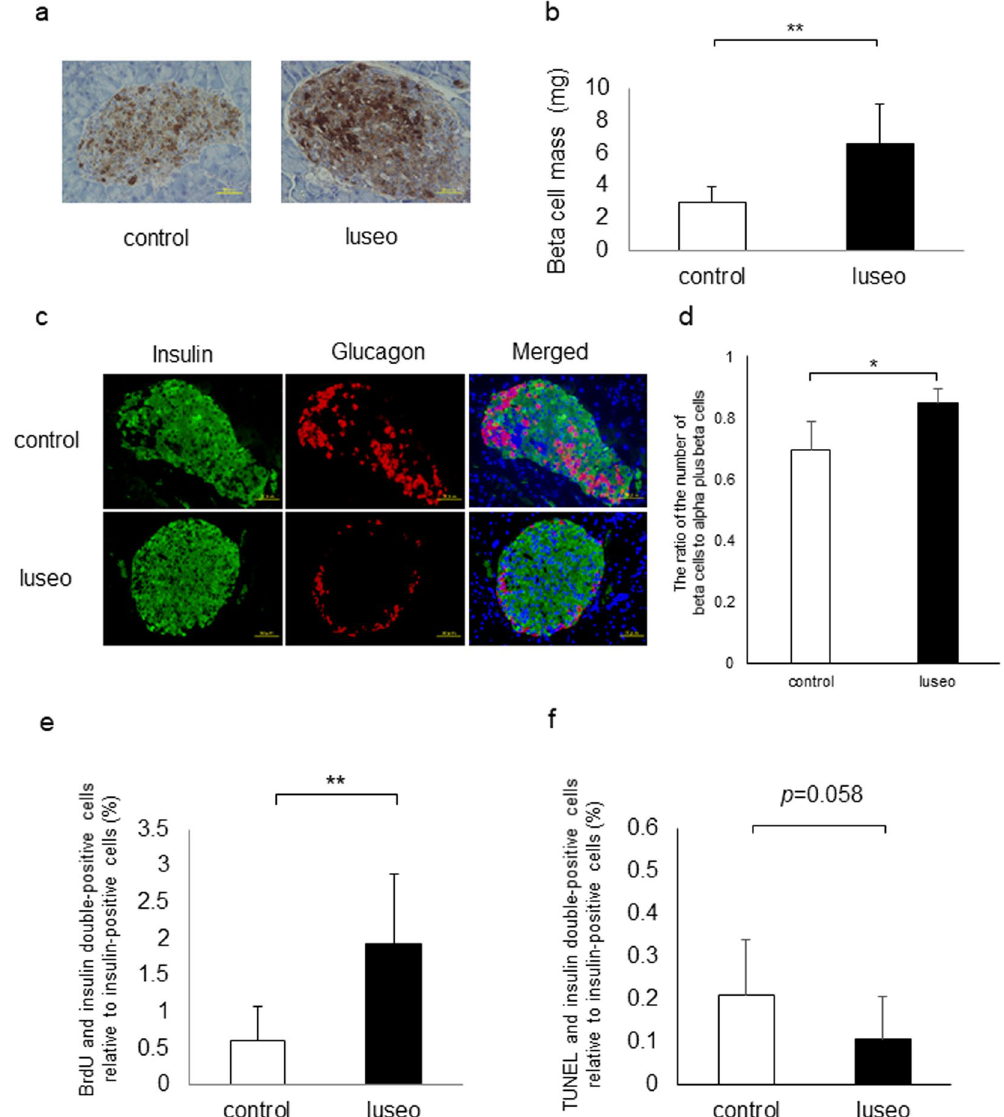
Figure 2. Impact of luseogliflozin on beta cell morphology in 6-week-old db/db mice. ( a) Histological analysis of pancreatic islets of db/db mice with or without luseogliflozin for 4 weeks. Beta cells are stained brown. ( b ) Quantitation of beta cell mass in the control group (white bar) and the luseo group (black bar) ( n = 8: eight mice were used in each group). ( c ) Representative insulin (green) and glucagon (red) staining in pancreas sections from the control group and the luseo group. ( d ) The ratio of the number of beta cells to the sum of alpha plus beta cells in pancreatic islets in the control group (white bar) and luseo group (black bar) ( n = 5: five mice were used in each group). ( e ) Proliferation rate of beta cells assessed using BrdU incorporation in the control group (white bar) and the luseo group (black bar) ( n = 8: eight mice were used in each group). ( f ) Apoptosis rate of beta cells assessed using the TUNEL assay in the control group (white bar) and the luseo group (black bar) ( n = 10: ten mice were used in each group). Values are mean ± SD. * p < 0.05; ** p < 0.01. Scale bars: 50 μ